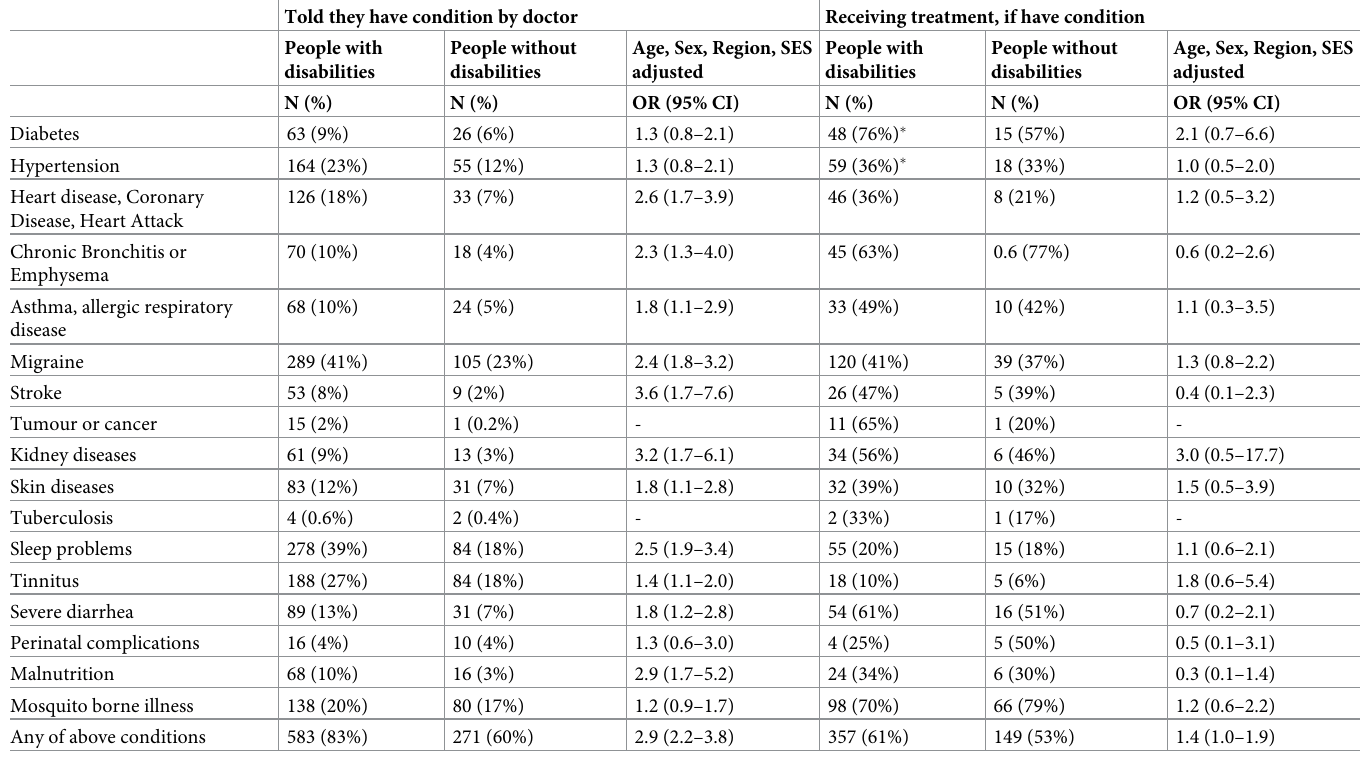
Table 3. Coverage of treatment for general health conditions, comparing people with and without disabilities.